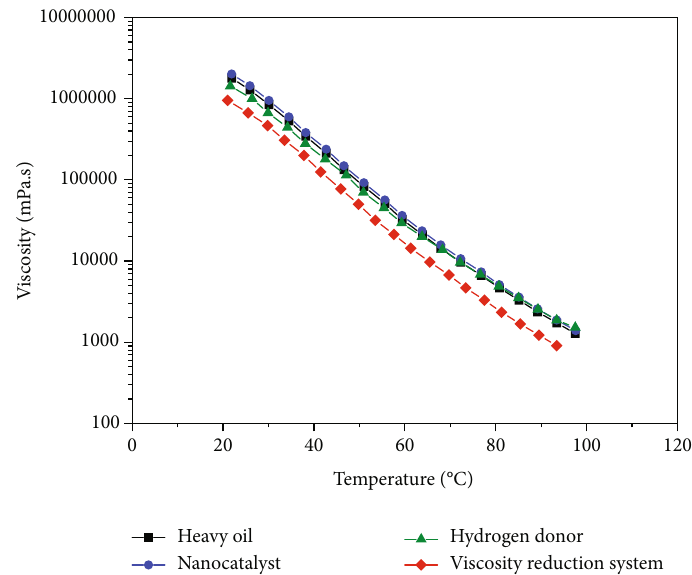
Figure 6: Viscosity-temperature curves of heavy oil obtained from each group of experiments.